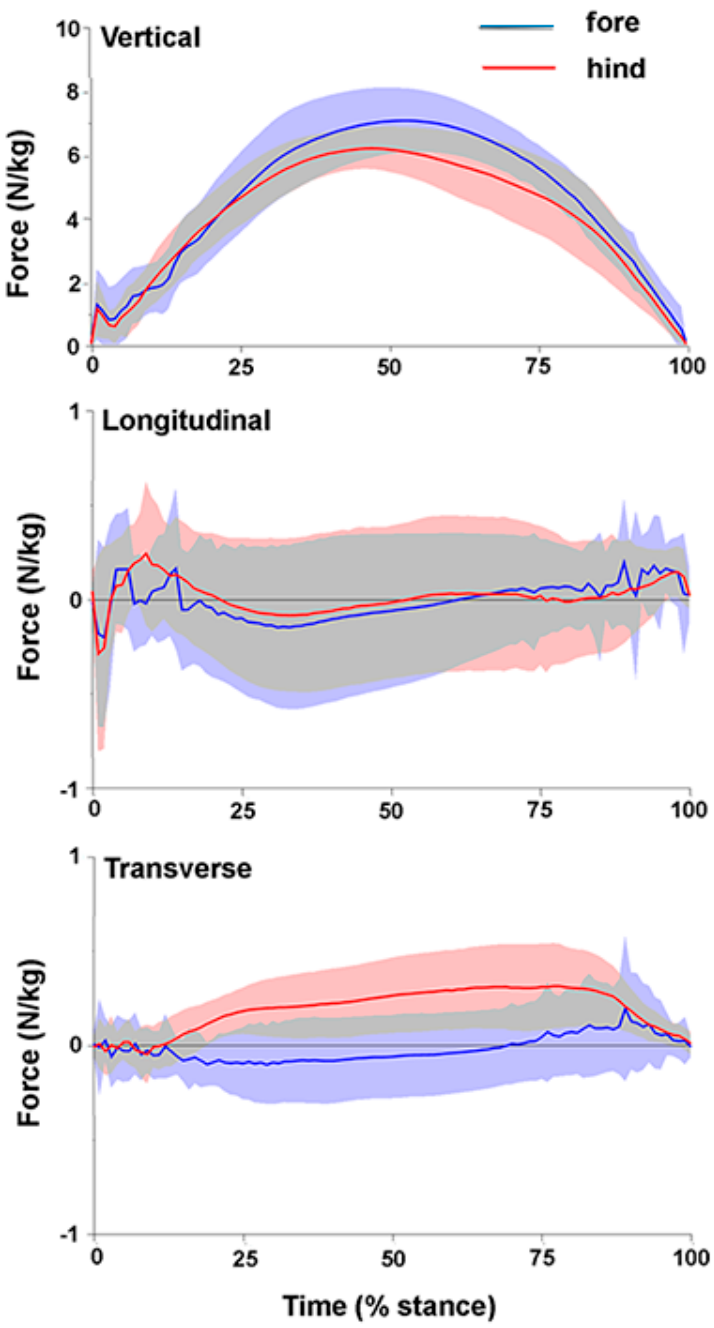
Figure 2. Mean values (bold lines) and SD bands (shaded areas) (N = 7 horses) for vertical (above), longitudinal (middle) and transverse (below) ground reaction forces for the forelimbs (blue) and hindlimbs (red). Overlapping areas of the SD bands are shown in grey.